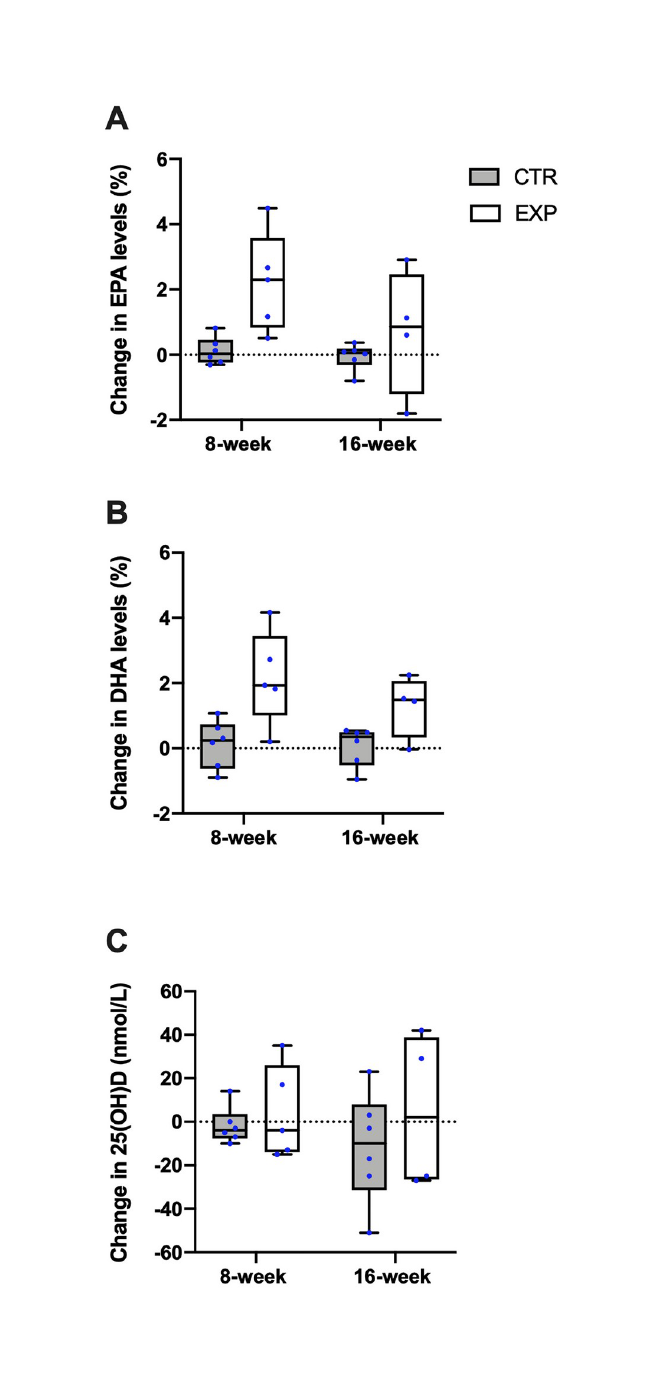
Fig 2. Boxplots showing changes between baseline and week 8, and week 16 in (A) plasma phospholipid EPA, (B) DHA, (C) serum 25(OH)D by group. Boxes are interquartile ranges and horizontal lines inside boxes are medians. Whiskers represent the minimal and maximal value and the blue dots represent the participants’ individual value. The dotted lines indicate a change of 0.